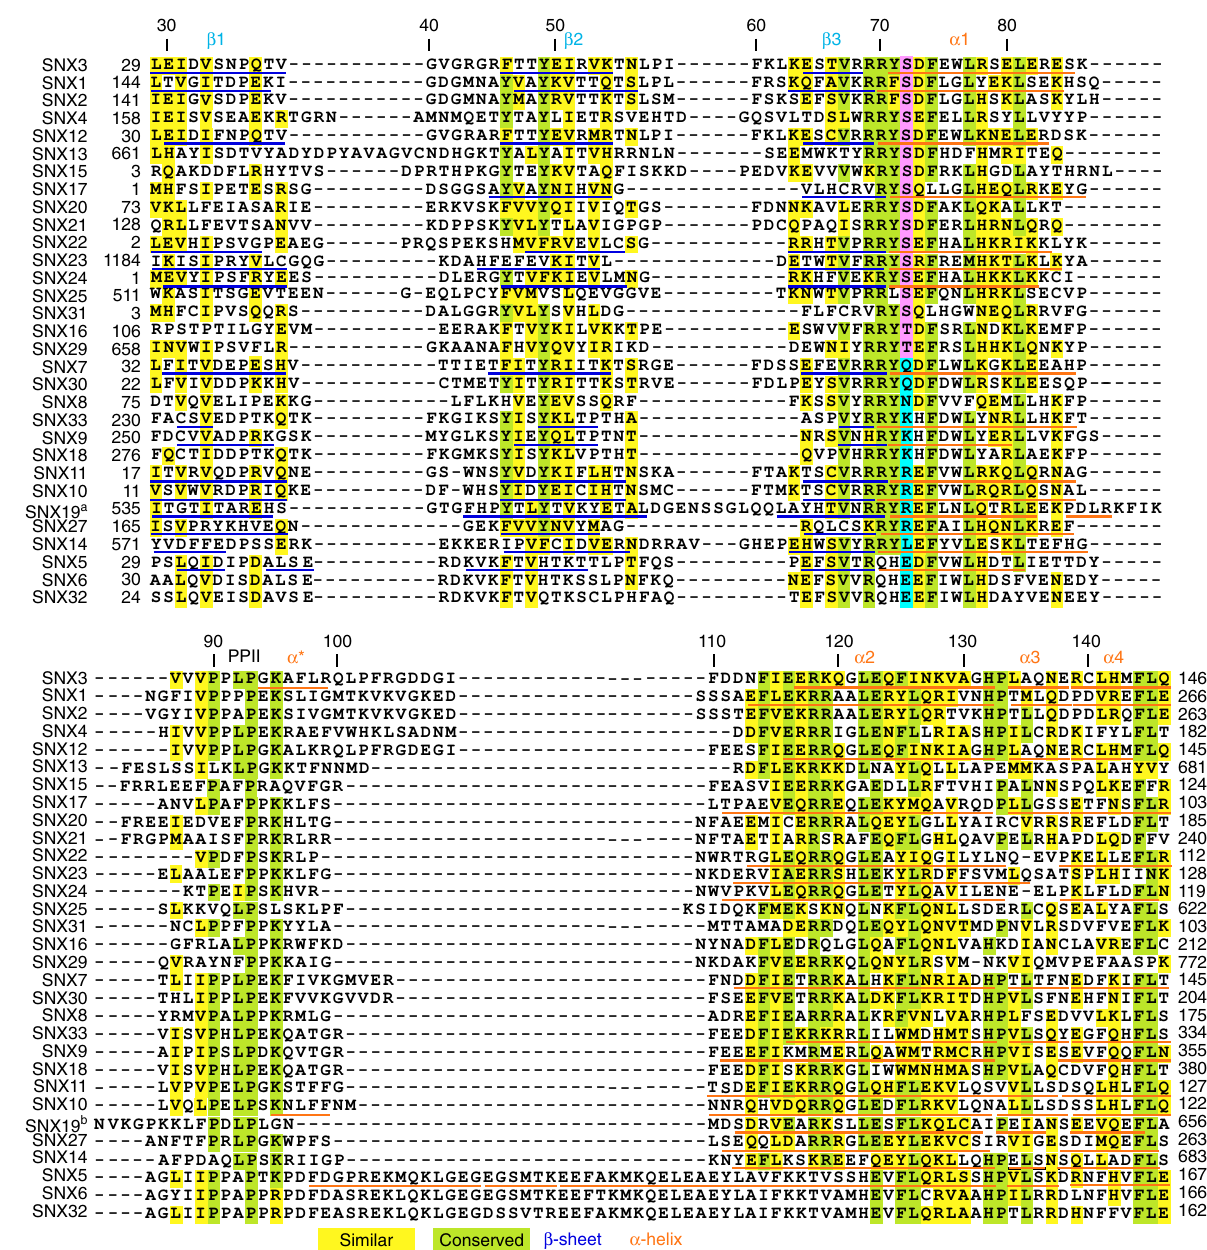
AMHEVFLQRLAAHPTLRRDHNFFVFLEKSK Fig. 4 Multiple sequence alignment of SNX PX domains. Alignment of PX domain sequences from the human sorting nexin proteins. Identical, conserved and similar residues are colored green, cyan, and yellow, respectively, while the critical conserved serine residues are in magenta and substituted residues are in blue. Known secondary structure elements are indicated under the residues. All alignments were produced using the ClustalW 1.6 similarity matrix 53 and corrected to align structural elements. Numbers of the boundary amino acids are indicated on the sides, while every tenth residue of human SNX3 is indicated SNX3 structure indicates that phosphorylation here would pre- vent ligand binding by blocking inositol 3-phosphate entry and negating the optimal membrane docking propensity here. (Supplementary Fig. 1d). Compared to the wild-type form, selective membrane binding activity was retained by S72A mutant